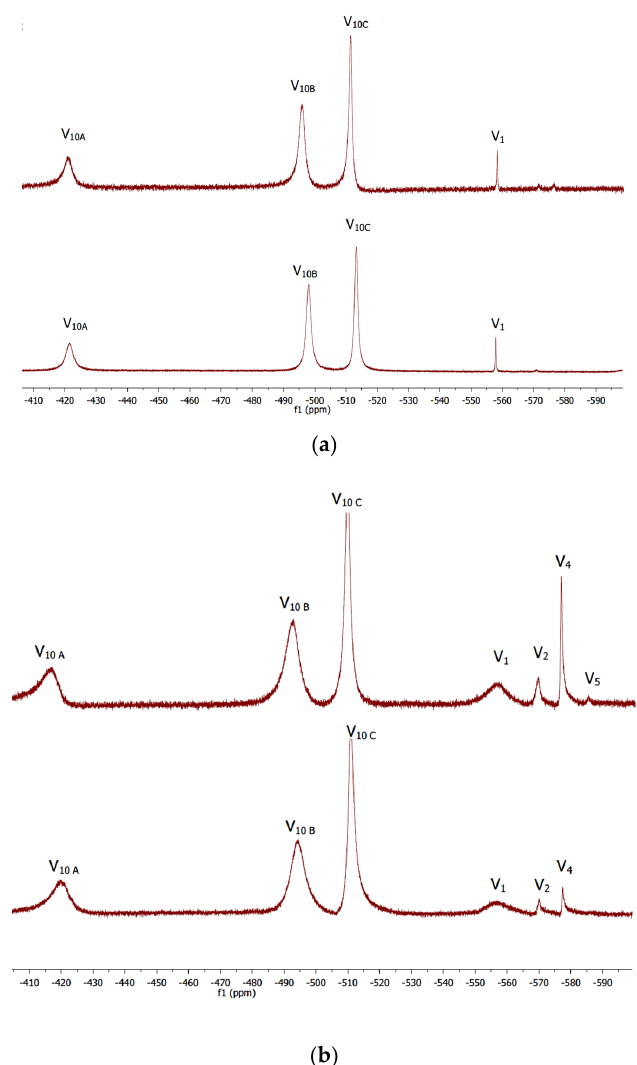
Figure 2. 51 V NMR spectra of ( a ) 1 mM NaDeca (top) and MetfDeca (bottom) in 10% DMSO- d 6 and 90% H 2 O ( v / v ) DMSO at pH 4, ( b ) 1 mM NaDeca (top) and MetfDeca (bottom) in DMEM medium at pH